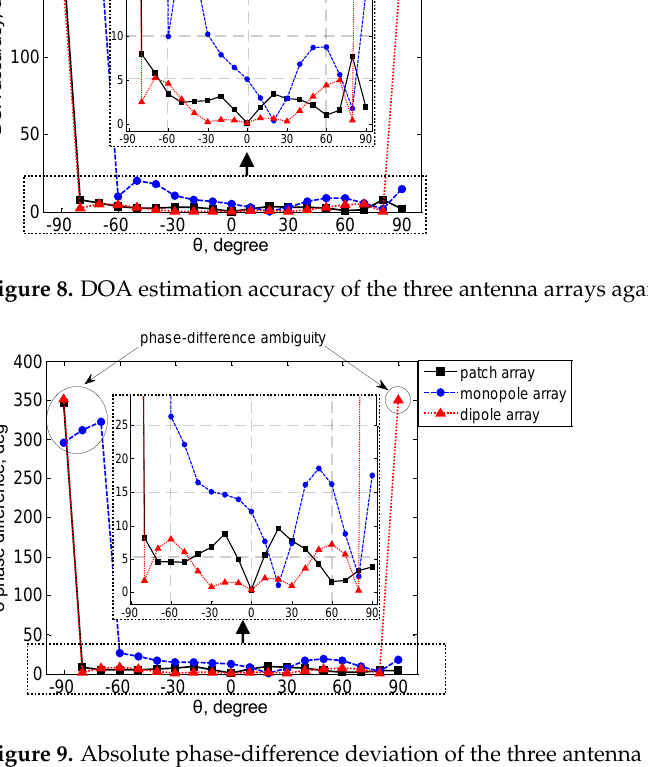
Figure 9. Absolute phase-difference deviation of the three antenna arrays against DOA (θ). Since the two-element array only estimated DOA from the front semicircle in the horizontal plane, a good front-to-back ratio is required for the anchor antennas. Figures 6b and 10 show that the front side of the two high linear–polarization arrays has a higher gain and better XPD in the front semicircle than in the back semicircle. The front-to-back ratio was over 10 dB. This removes the reverse ambiguity caused by strong back radiation in the DOA estimation. In contrast, Figure 8 shows that the monopole array is prone to reverse ambiguity in the DOA estimation due to its poor front-to-back ratio.